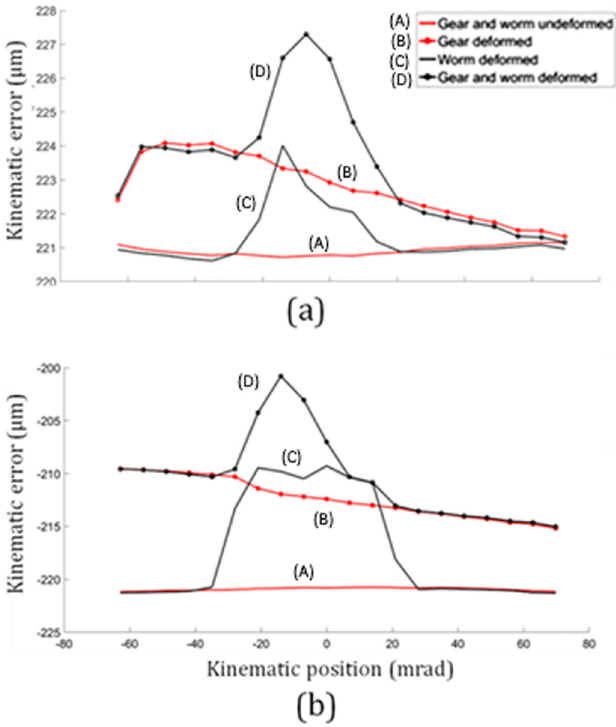
Fig. 9. Example of kinematic errors: (a) anti-clockwise, (b)